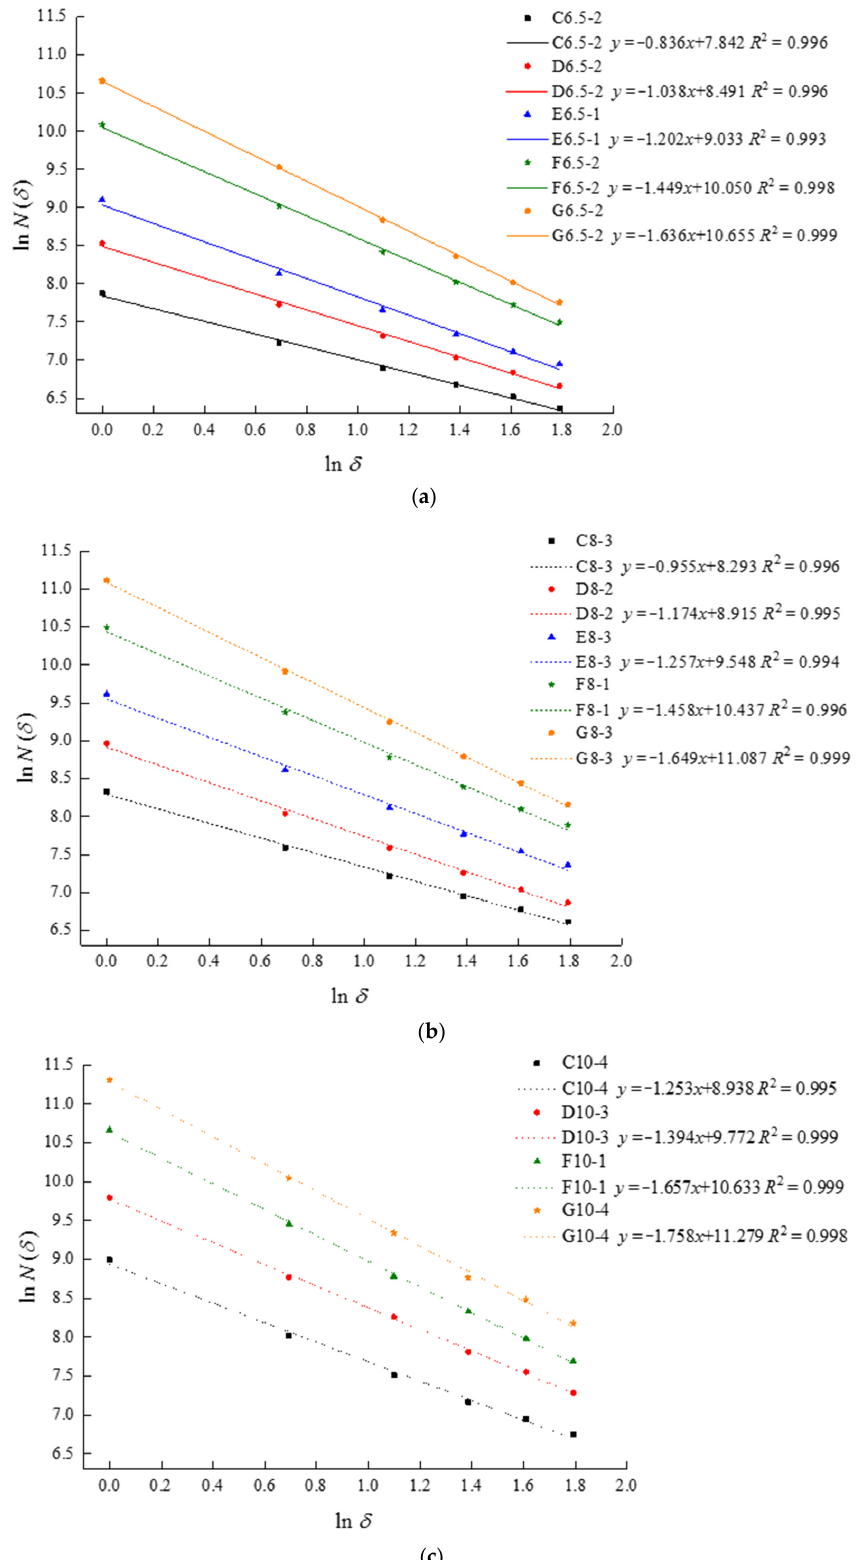
Figure 7. Double logarithm diagram for fractal dimension of specimens with different corrosion degrees: ( a ) Double logarithm graph of d = 6.5 mm fractal dimension; ( b ) Double logarithm graph of d = 8 mm fractal dimension; ( c ) Double logarithm graph of d = 10 mm fractal dimension. As presented in Figures 7 and 8, the fractal dimension and the intercept of the fitted line increase as corrosion progresses for the same steel bar diameter. For example, the ln N values for a 10 mm diameter specimen were 9.02, 9.76, 10.72, and 11.28 for 15%, 20%, 25%, and 30% corrosion degrees, respectively. The fractal dimension decreased with the steel bar diameter; however, as the corrosion rate increased, the fractal dimension incre- ment of the steel bar with a small diameter increased. At the same corrosion level, the steel bars with larger diameters yielded higher volumes of rust as compared with those with a smaller diameter. Consequently, greater circumferential tensile stresses of concrete were generated around the steel bars, in addition to a more rapid cracking development and the generation of more complex crack patterns. However, as the corrosion rate increased and the cracks developed to a certain degree of severity, the cracks and voids of concrete generated around the steel bars enabled the corrosion products to spread and overflow.